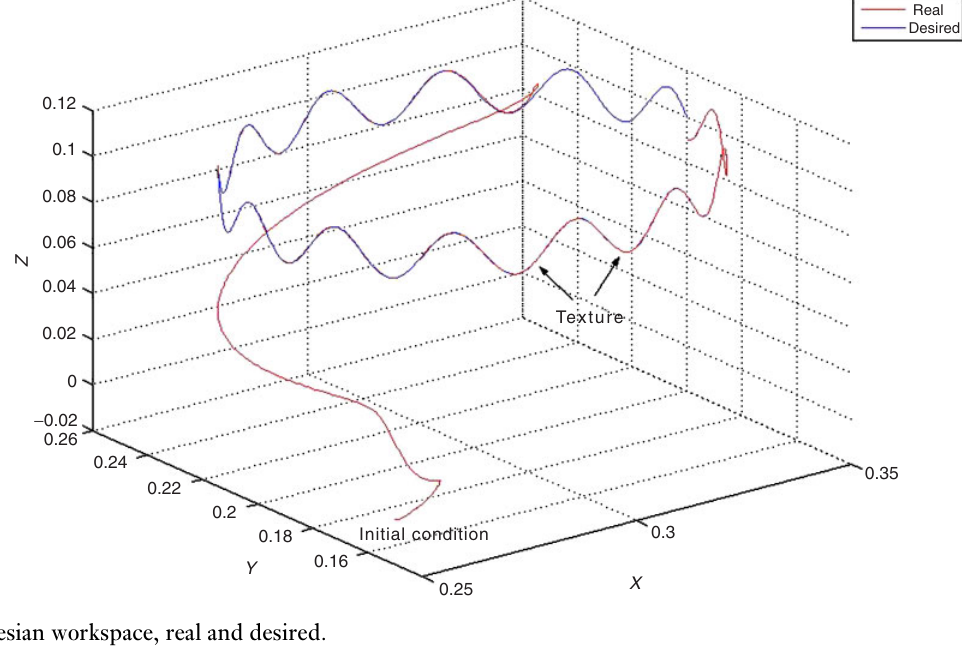
Figure 4 Cartesian workspace, real and desired.